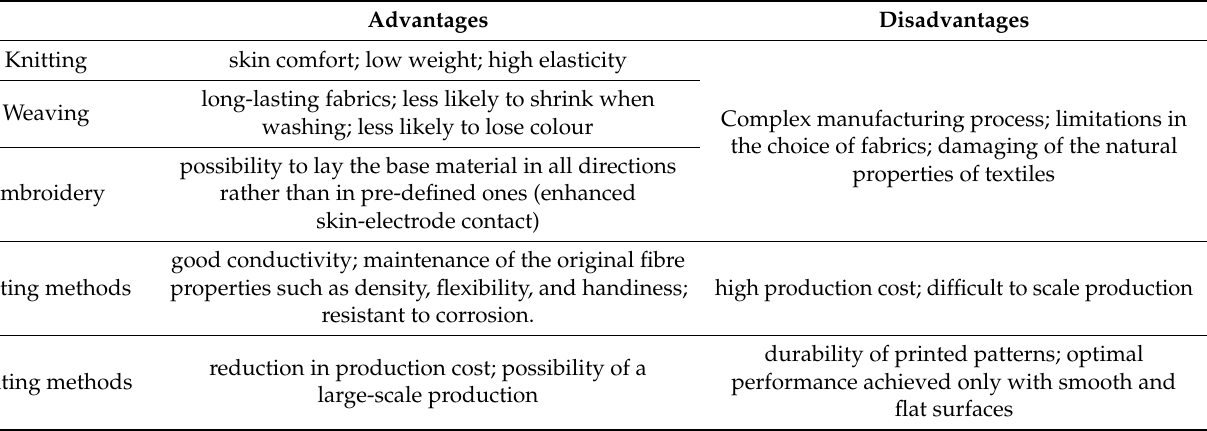
Table 1. Synthesis of the main advantages and disadvantages of the manufacturing